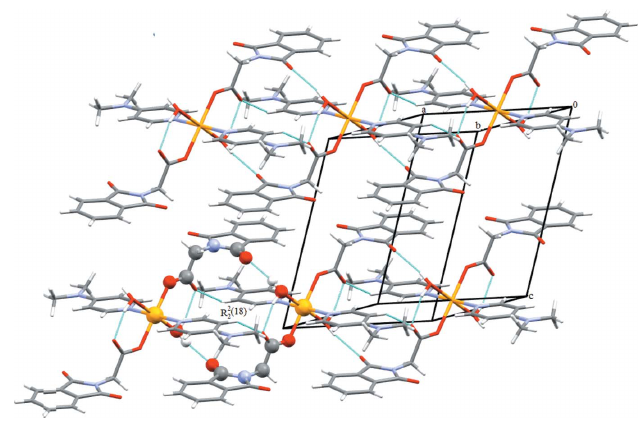
Figure 2 Partial view of the crystal structure of the title compound showing the formation of R 2 (18) rings. The C—H (cid:2)(cid:2)(cid:2) O and O—H (cid:2)(cid:2)(cid:2) O hydrogen bonds 2 are shown as dashed lines.